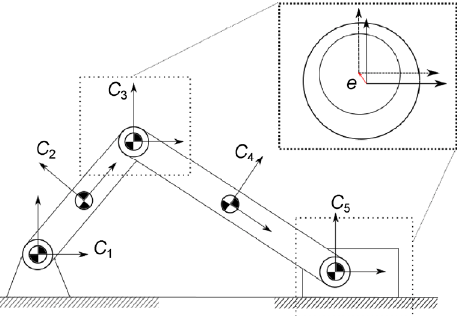
Fig. 13 Wear analysis integrated with the dynamics based on Ref.